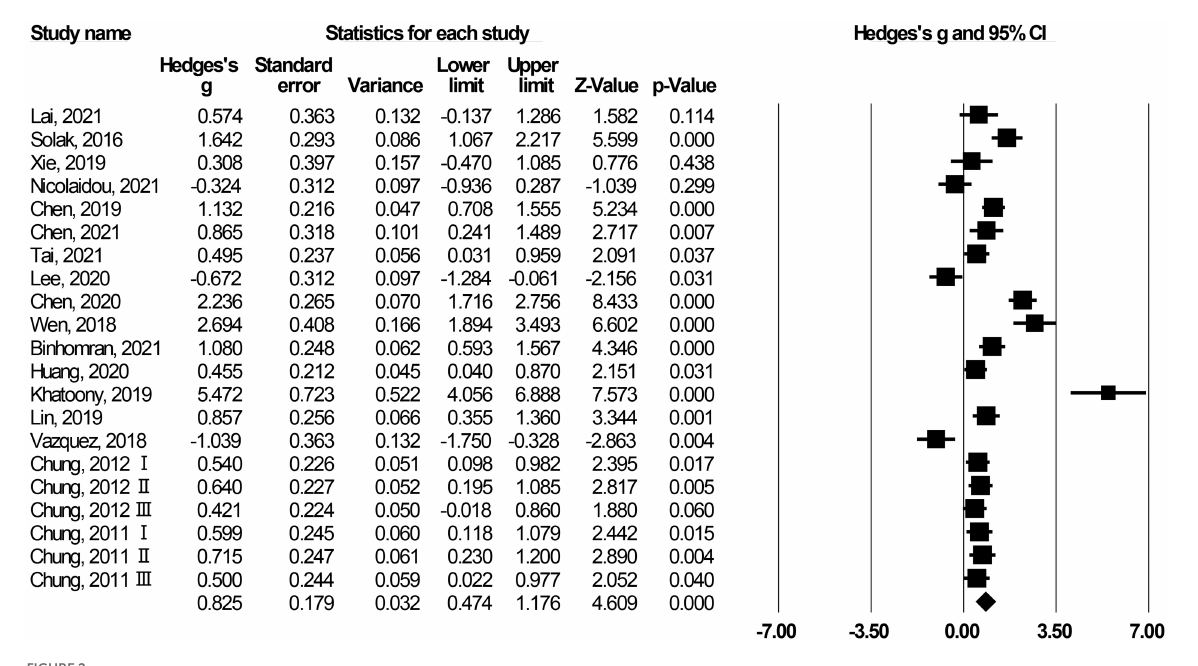
FIGURE 2 Forest plot for the impacts of XR on language